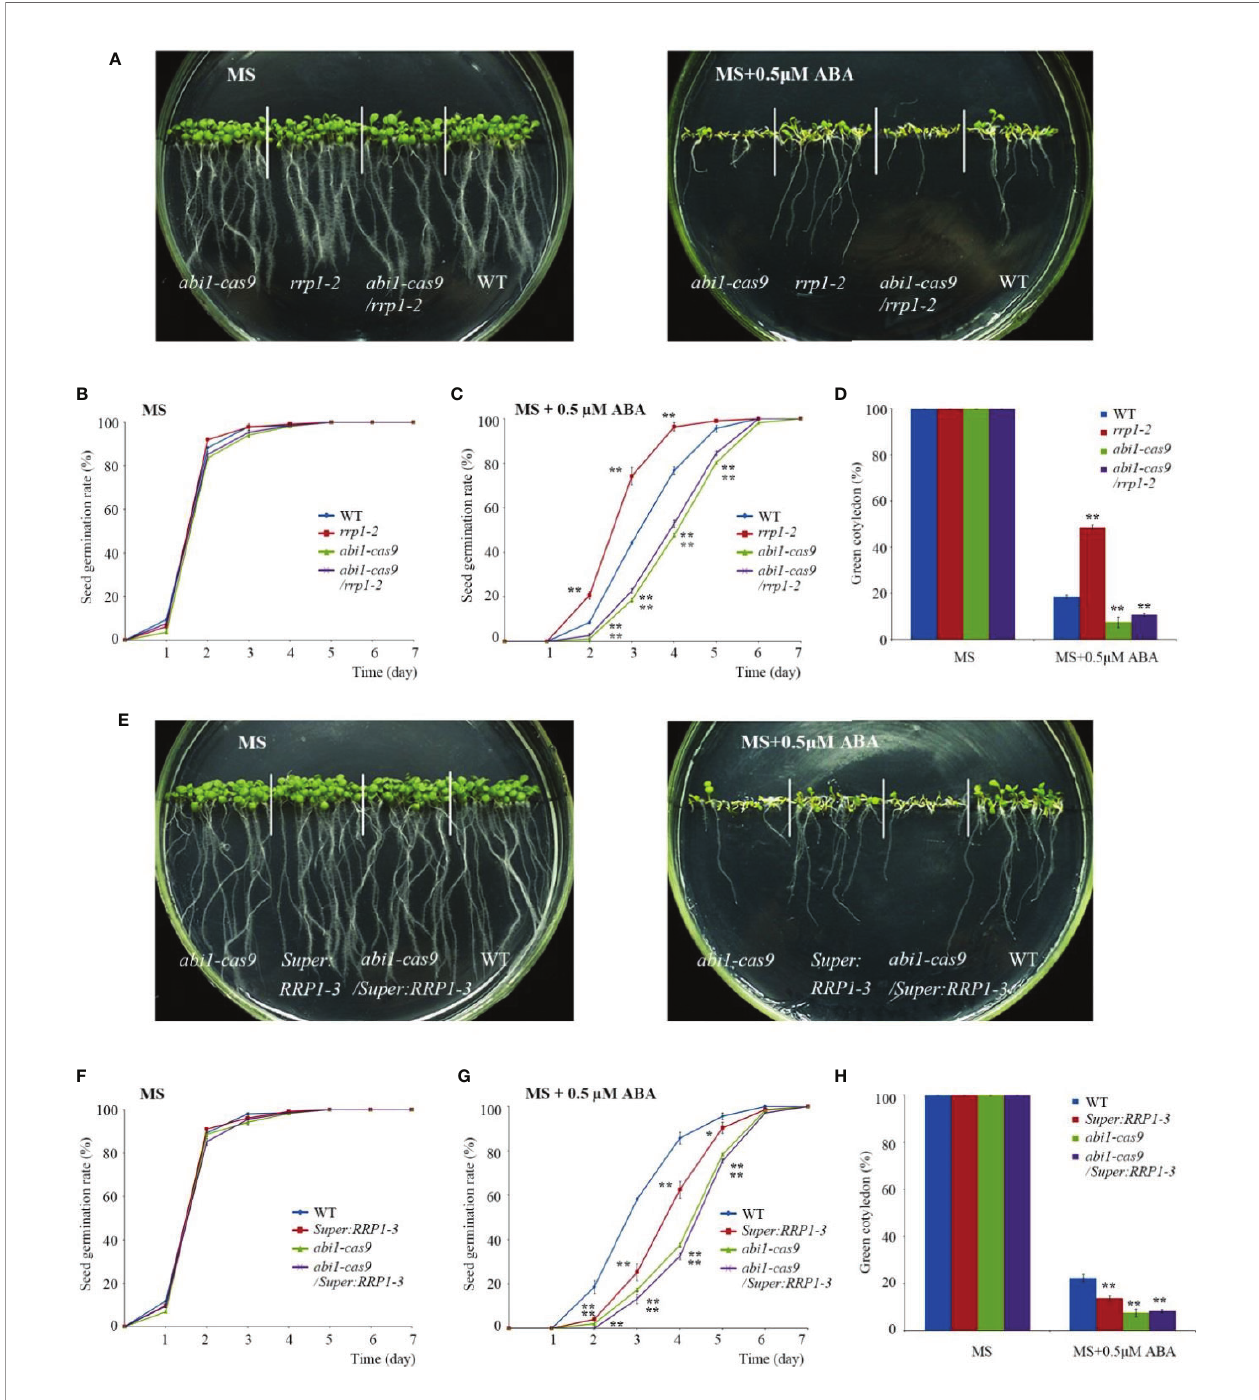
FIGURE 6 | Function of RRP1 upstream of ABI1. (A) Phenotypic comparison analysis. Imbibed seeds were transferred to Murashige and Skoog (MS) and MS + 0.5 m M abscisic acid (ABA) medium and grown for 9 days. (B, C) Seed germination assay. Imbibed seeds were transferred to MS (B) and MS medium supplemented with 0.5 m M ABA (C) . The seed germination frequency was calculated at a given time. Data are the mean ± SE ( n = 3). More than 300 seeds were measured in each replicate. (D) Cotyledon-greening analysis. Imbibed seeds were transferred to MS or MS + 0.5 m M ABA medium for 7 days before determination of cotyledon-greening percentage. Data are the mean ± SE ( n = 3). More than 300 seeds were measured in each replicate. (E) Phenotypic comparison analysis. Imbibed seeds were transferred to MS and MS + 0.5 m M ABA medium and grown for 11 days. (F, G) Seed germination assay. Imbibed seeds were transferred to MS (B) and MS medium containing 0.5 m M ABA (C) . The seed germination frequency was calculated at a given time. Data are the mean ± SE ( n = 3). More than 300 seeds were measured in each replicate. (H) Cotyledon-greening analysis. Imbibed seeds were transferred to MS or MS + 0.5 m M ABA medium for 7 days before determination of cotyledon-greening percentage. Data are the mean ± SE ( n = 3). More than 300 seeds were measured in each replicate. Asterisks indicate statistically signi fi cant differences compared with the wild-type plants: *, P < 0.05; **, P <